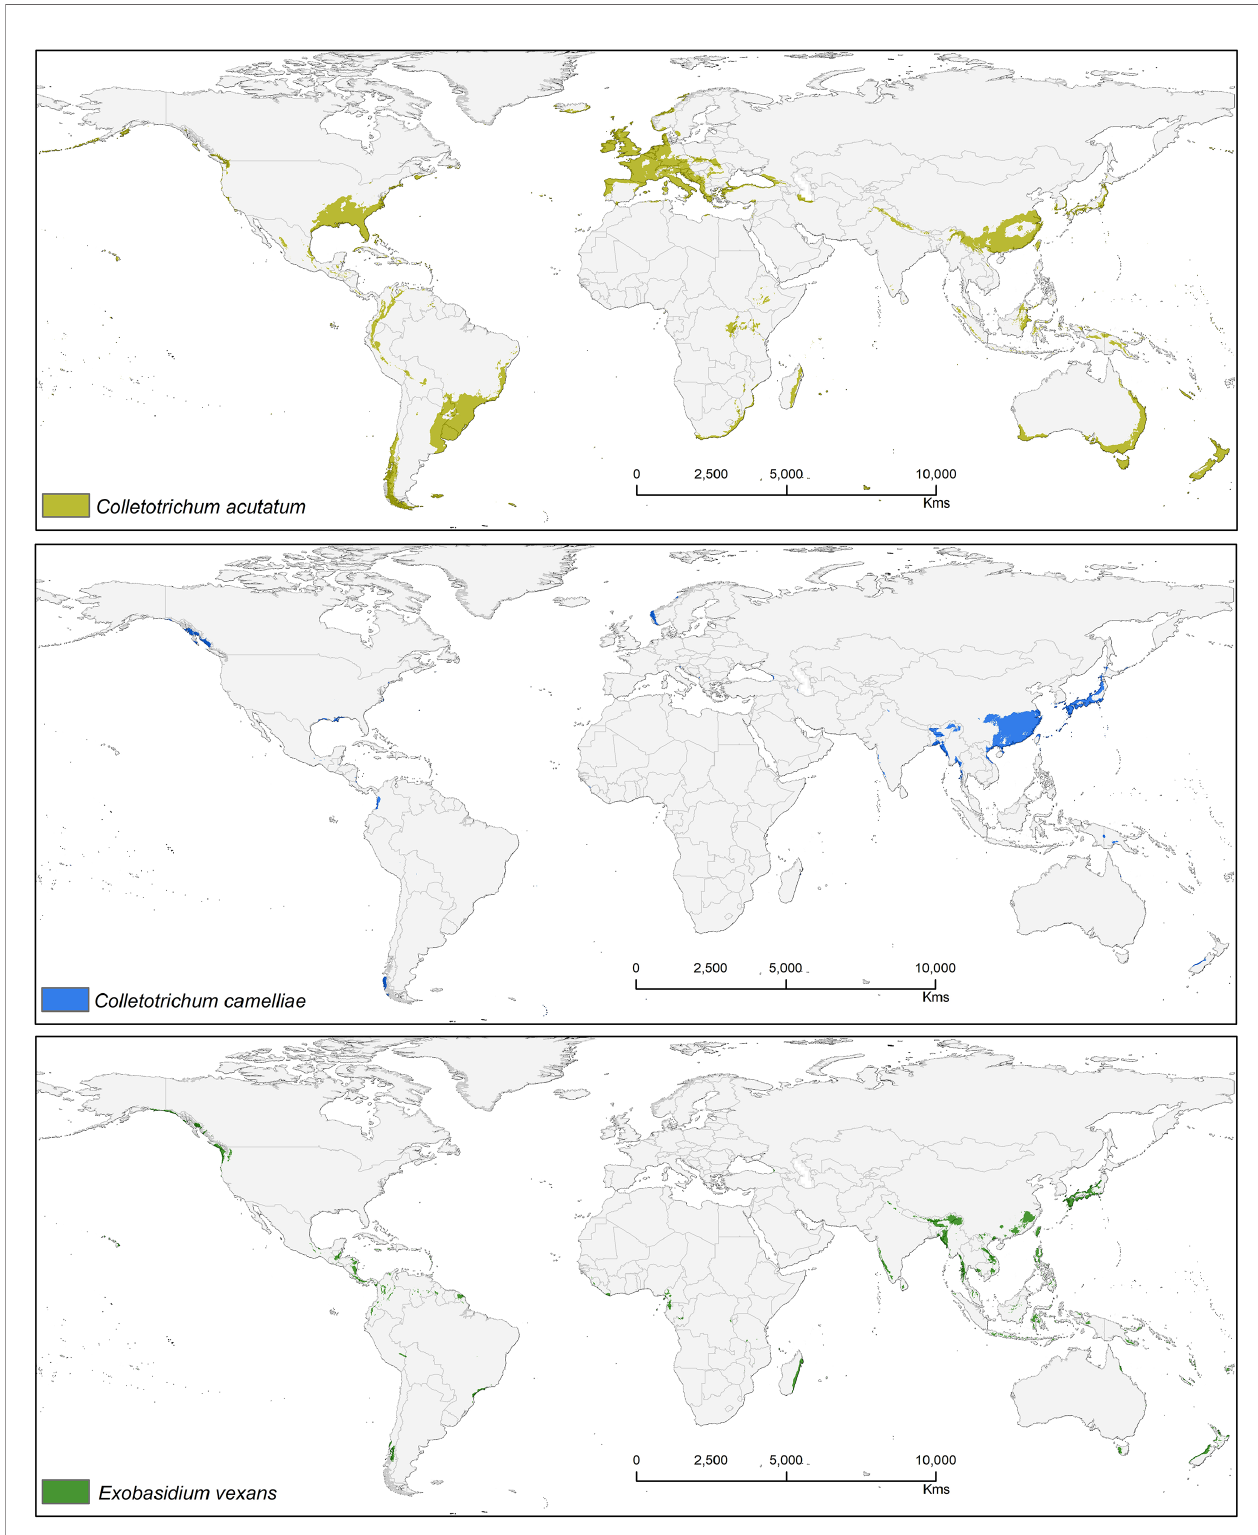
FIGURE 4 | Bioclimatic suitability for three major fungal pathogens: Colletotrichum acutatum, Colletotrichum camelliae , and Exobasidium vexans .